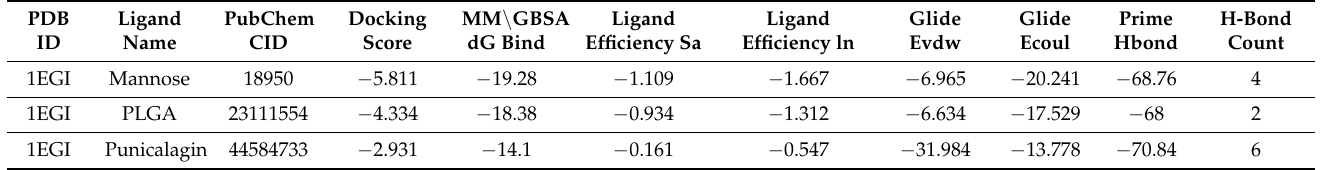
Table 1. The docking score MM \ GBSA score and other energies of the protein–ligand